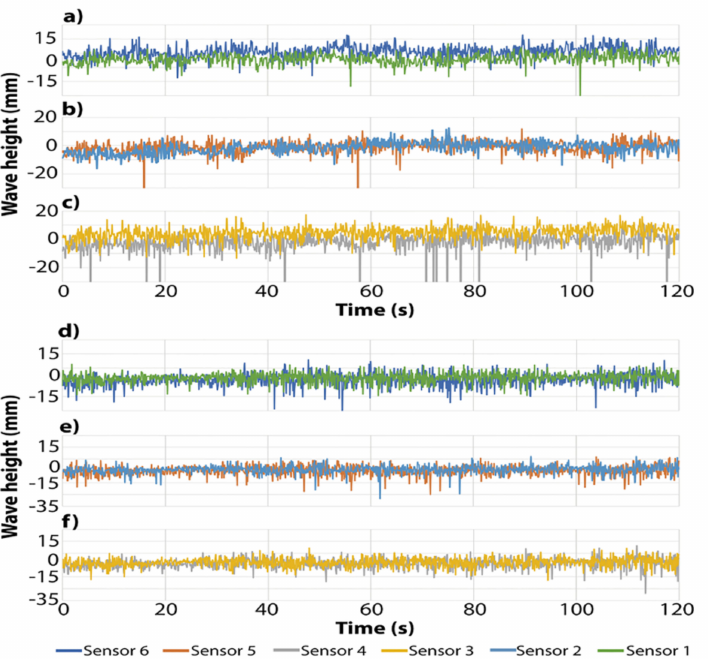
Figure 9. Variations in the meniscus level using nozzles without clogging. ( a ) Sensors 1 and 6 with nozzle A. ( b ) Sensors 2 and 5 with nozzle A. ( c ) Sensors 3 and 4 with nozzle A. ( d ) Sensors 1 and 6 with nozzle B. ( e ) Sensors 2 and 5 with nozzle B. ( f ) Sensors 3 and 4 with nozzle